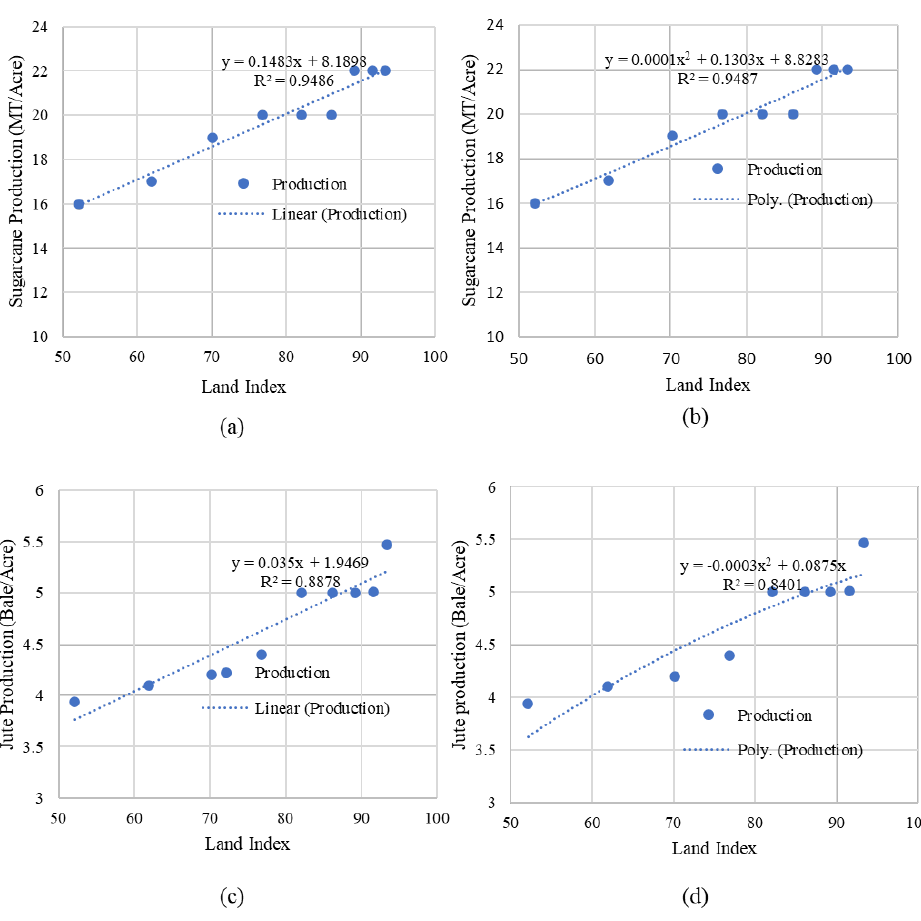
Figure 11. Validation of the fuzzy-based land suitability score referring to the average sugarcane and jute production from different administrative districts of Bangladesh. ( a ) Linear regression for sugarcane; ( b ) polynomial regression for sugarcane; ( c ) linear regression for jute and ( d ) polynomial regression for jute.